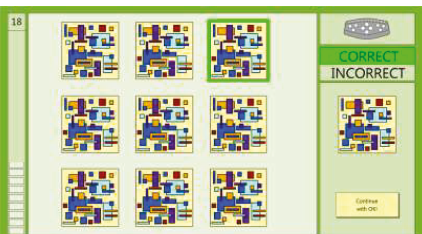
Figure 4: Example of a screen with a 3 by 3 matrix on level 18 of the attention and concentration RehaCom module.